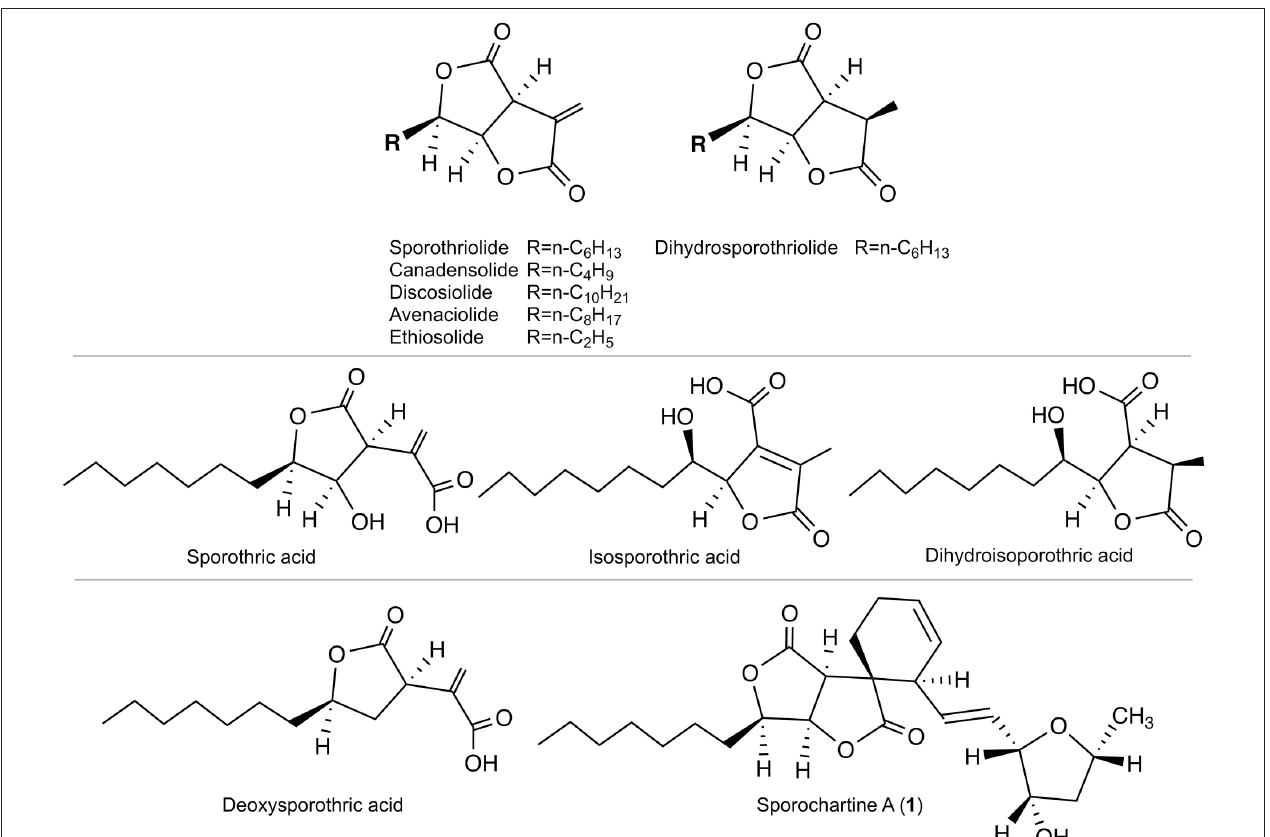
FIGURE 1 | Top: Sporothriolide and analogs reported in 1994 (Krohn et al., 1994). Middle: Monocyclic precursors reported in 2014 (Surup et al., 2014). Bottom: Deoxysporothric acid and sporochartine A reported in our previous work (Leman-Loubière et al.,